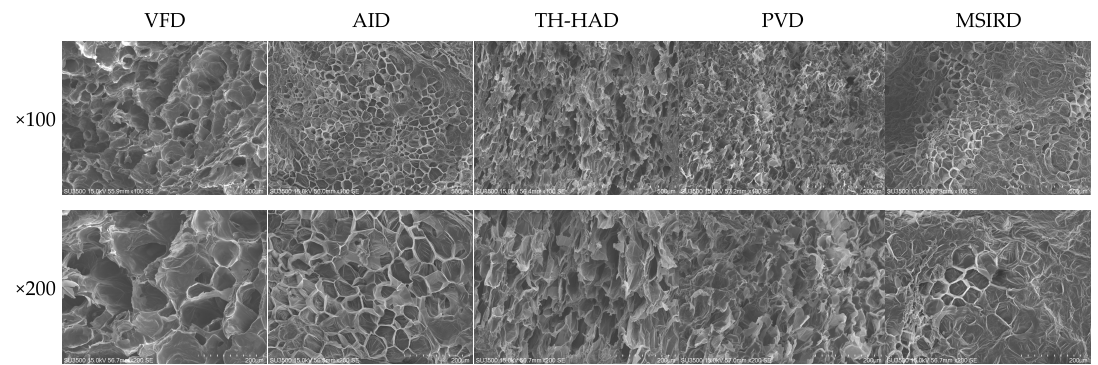
Figure 7. The microstructure of garlic slices dried in different methods at 100 and 200 magnifica- tions. Table 2. Images and color parameters of garlic slices under various drying methods. Fresh VFD AID TH-HAD PVD MSIRD